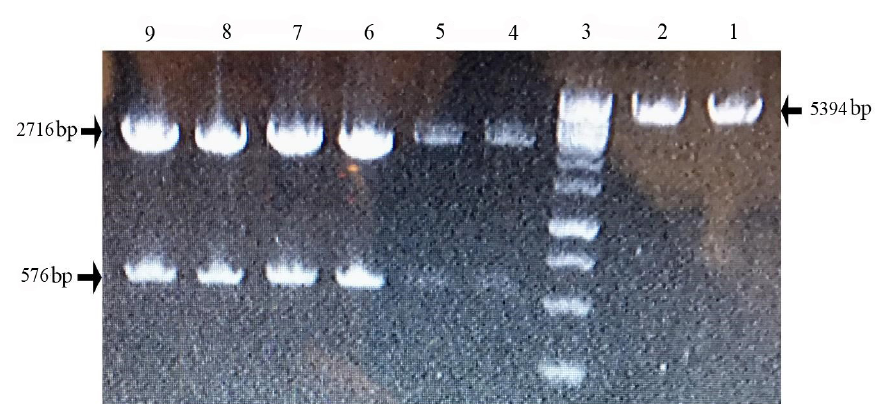
Figure 3. Enzymatic digestion product of pUC57-IFN β 1a and pcDNA3.1 plasmids by EcoRI and XhoI enzymes. Lines 1 and 2: pcDNA3.1 vector. 3: 1kb DNA ladder. Lines 4-9: plasmid extracts containing bp2716-pUC57 vector body bands and 576 bp-IFN β 1a bands.